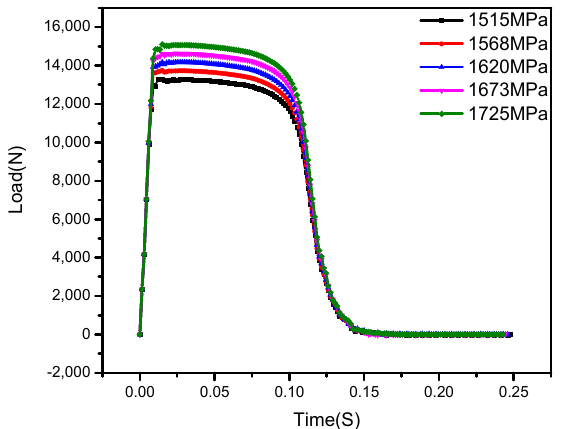
Figure 11. Tensile loads under different tensile strengths with a notch bottom diameter of 2.8